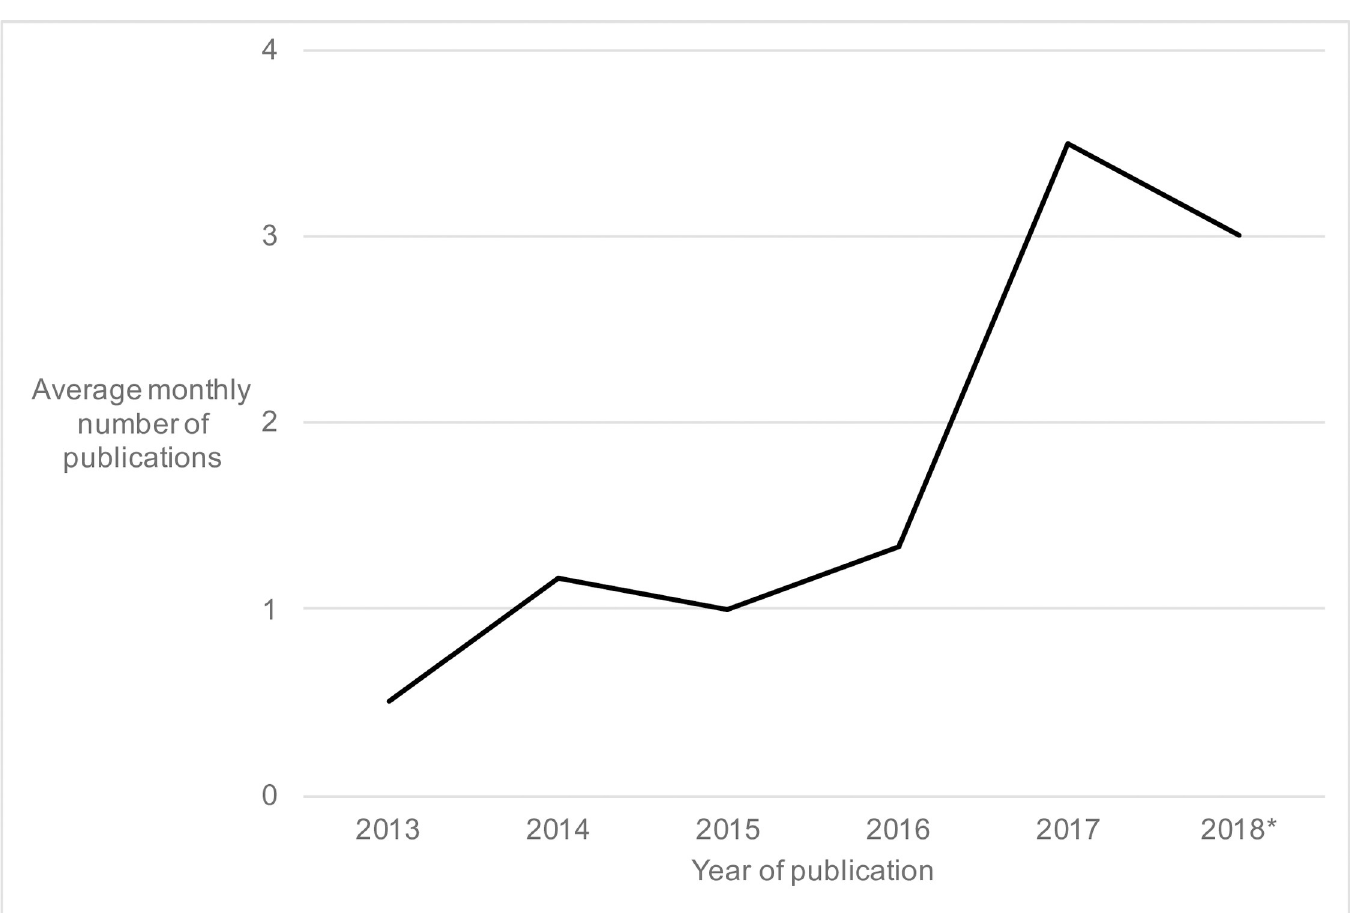
Fig 2. Average monthly number of publications included in the scoping review, for each year since 2013, out of a total of 96. � Year-to-date on March 1 st 2018.